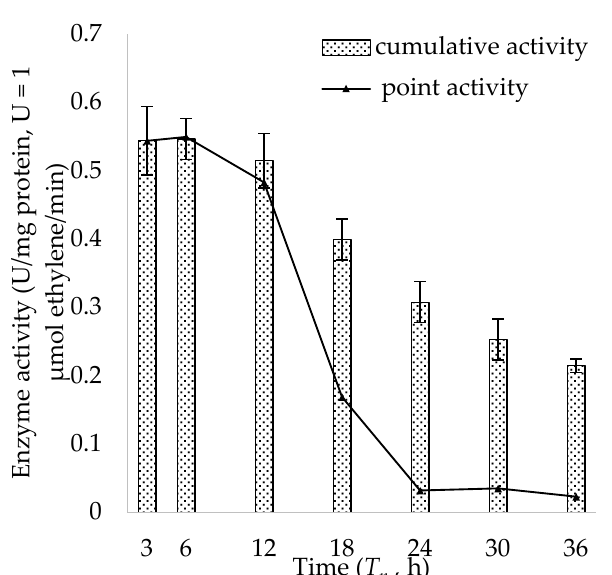
Figure 7. The change of enzymatic activity in vitro (Efe _ PS as a representative) with time at 20 °C: cumulative activity: activity from 0 h to T n h; point activity: activity from T n − 1 h to T n h.